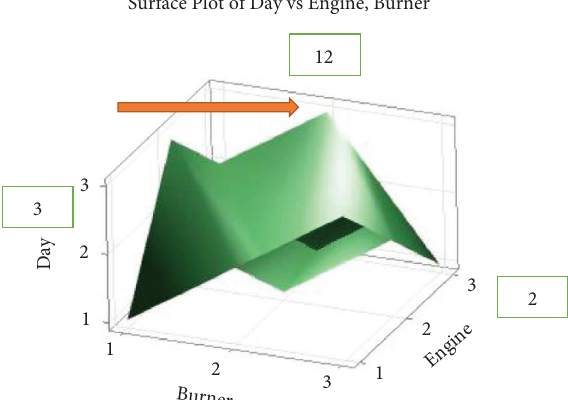
Figure 19: 3D plots of day vs. engine and